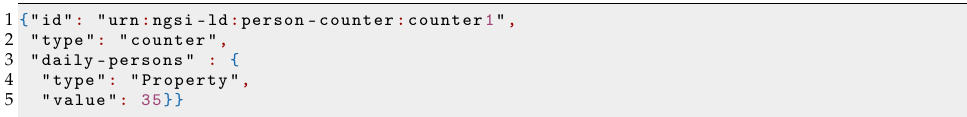
Table 6. NGSI-LD PATCH message updating the daily-person Property of the Entity in Table 1 from 30 to 35.